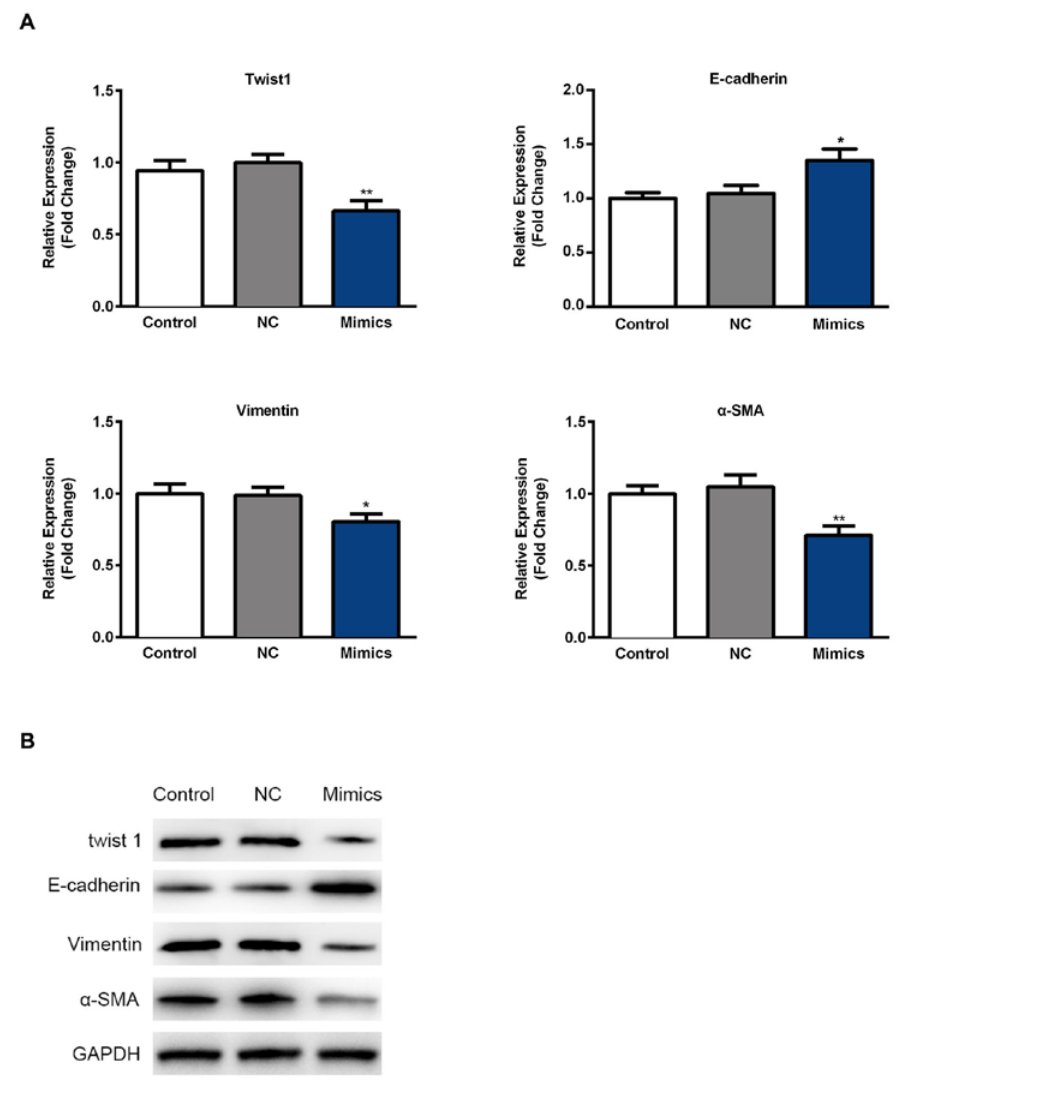
Figure 8: Effect of of miR-16-1-3p on PM2.5 induced EMT in SMMC-7721 cells (A) RT-qPCR was performed on gene expressions related to EMT in PM2.5 treated SMMC-7721 cells. Results were normalized with the level of GAPDH control. (B) The expression levels of EMT related proteins were analyzed using Western blotting assay. GAPDH was used as the loading control. Data are presented as means ± SD. of three independent experiments. *, p < 0.05, **, p <